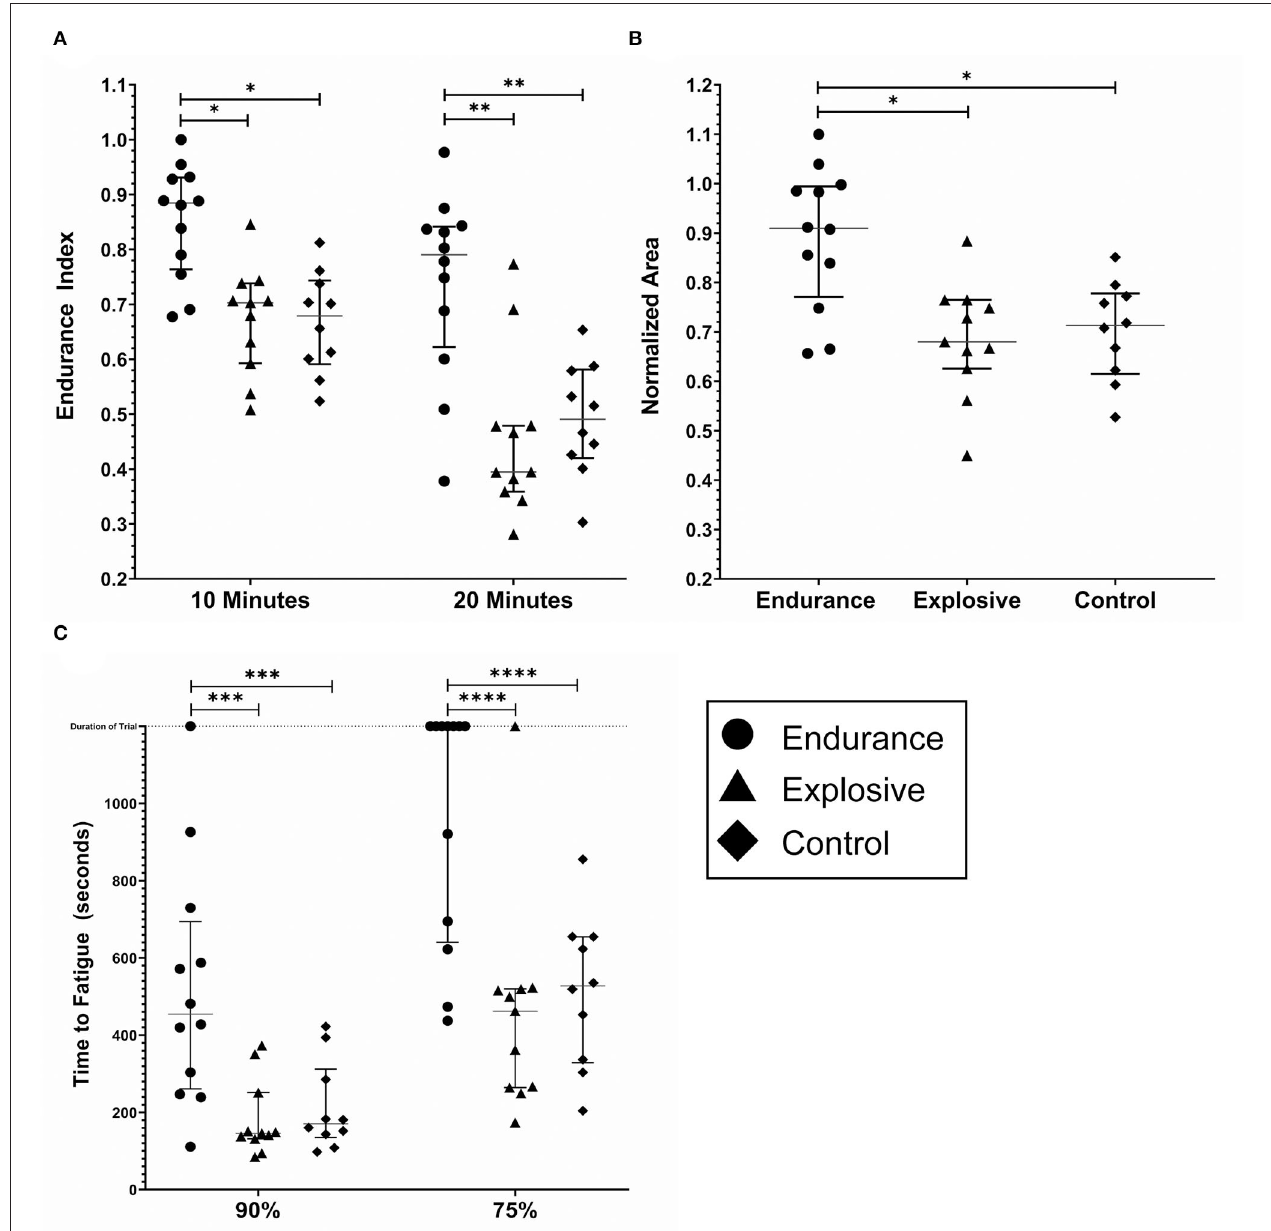
FIGURE 4 | Fatigue metrics by cohort; endurance ( n = 12), explosive ( n = 11) and control ( n = 10). (A) The endurance index as measured at the 10 and 20min timestamp. (B) The Normalized Area. Some subjects had calculated values above 1.0, due to the processing method. (C) The time to Fatigue to 90% and 75% of the initial force output. The duration of the trail was 1,200s and is noted by the dashed horizontal line. The lines within each data set denote the median and the interquartile range. *( p < 0.005) **( p < 0.0001) *** (p < 0.05) **** (p < 0.0005).